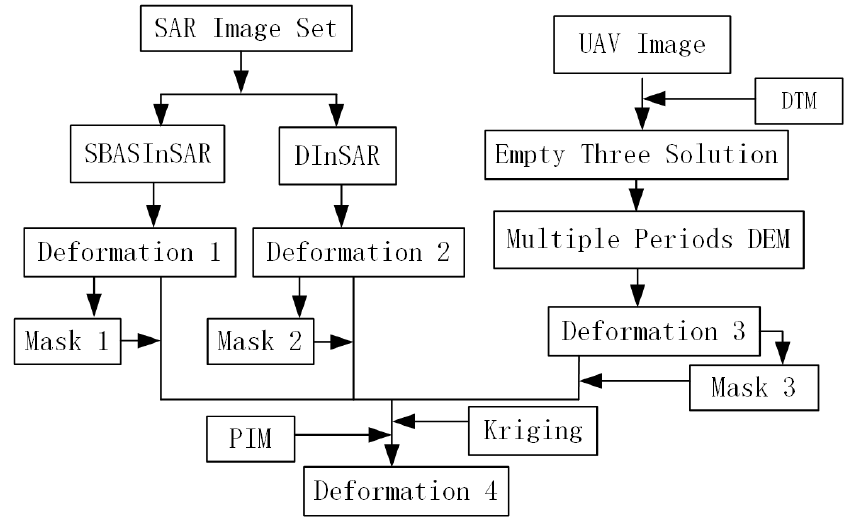
Figure 6. Flow chart of the fusion method.